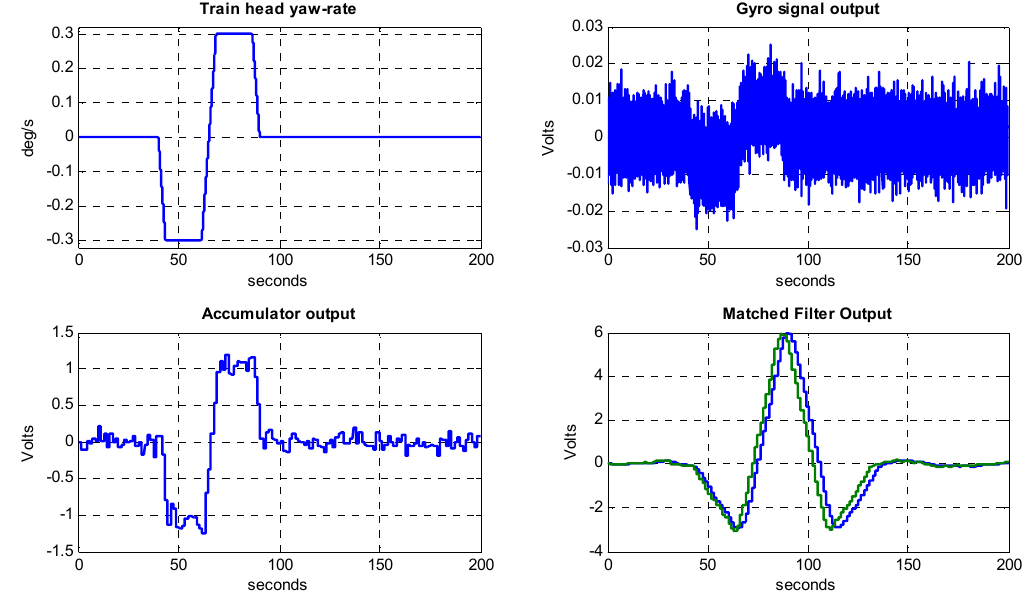
Figure 13. MATLAB ® -Simulink results of a 5 km/h simulation. Five signals are shown corresponding to the output ports 1 to 5 of the Simulink model. Top-left: port 1: actual yaw rate. Top-right: port 2: gyro output. Bottom-left: port 3: Accumulator output. Bottom-right: ports 4, 5: Blue is the ideal Matched Filter Output and Green is the Rectangular approximated Matched